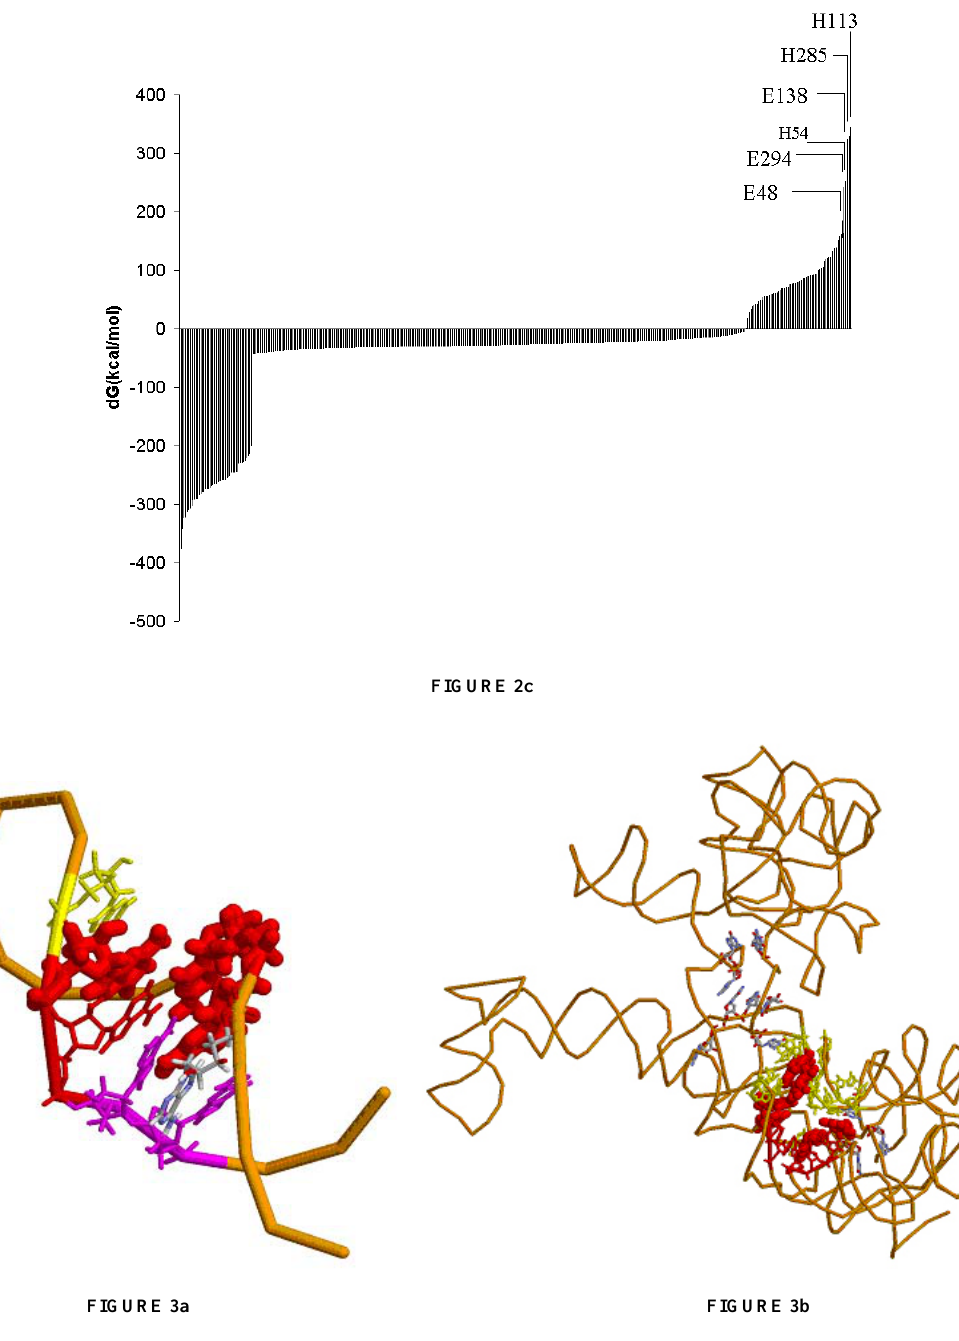
FIGURE 3 . The least stabilizing bases and the known functional residues in ribozymes. The known functional bases are in red (details are in Table 2), the known functional bases that were the least stabilizing are marked using thick lines. Residues less than 4 Å from the active site are in yellow, the rest of the “wire-frame” residues are “false positives”. The least stabilizing residues including “false positives” tend to cluster around the active site regions. (a) “Hairpin” ribozyme (PDB 1e4p). A9 stacks with the catalytic G8, residues of the cleavage site (magenta) were also the least stabilizing. (b) 23S catalytic fragment, the nucleotides identified using 0.95 E max cut off. (c) HDV ribozyme (PDB 1cx0), details are in the text. Typically, the “adjacent” nucleotides less than 4 Å from the known functional residues were forming base pairs or stacked with the functional residues. (d) Roles of the least and the most destabilizing nucleotides, active site (red) and protein-binding region (blue) in HDV ribozyme. The protein-binding nucleotides (sequence region 148–153) were the most stabilizing. The least stabilizing residues of the U1A-RBD protein (space filling) that interact with RNA are shown in